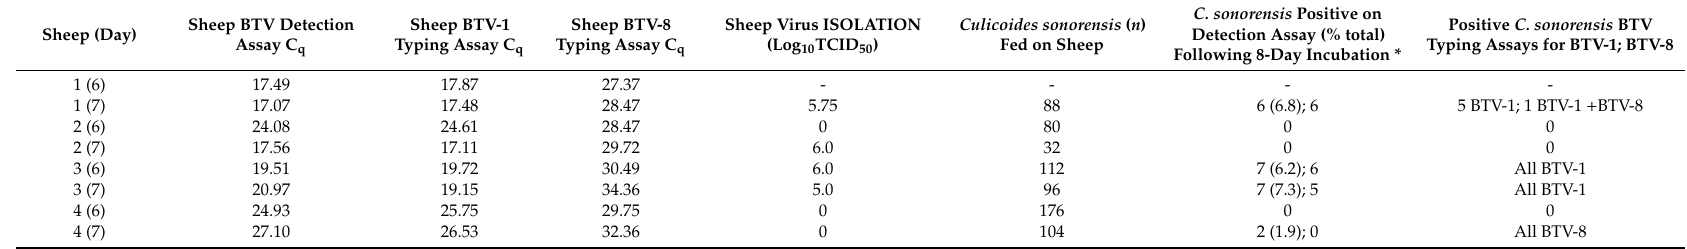
Table 3. Culicoides sonorensis blood feeding on sheep co-infected with BTV-1 and BTV-8. C. sonorensis were fed at day 6 and day 7 post infection of sheep with bluetongue virus and then stored for 8 days at 25 ◦ C prior to